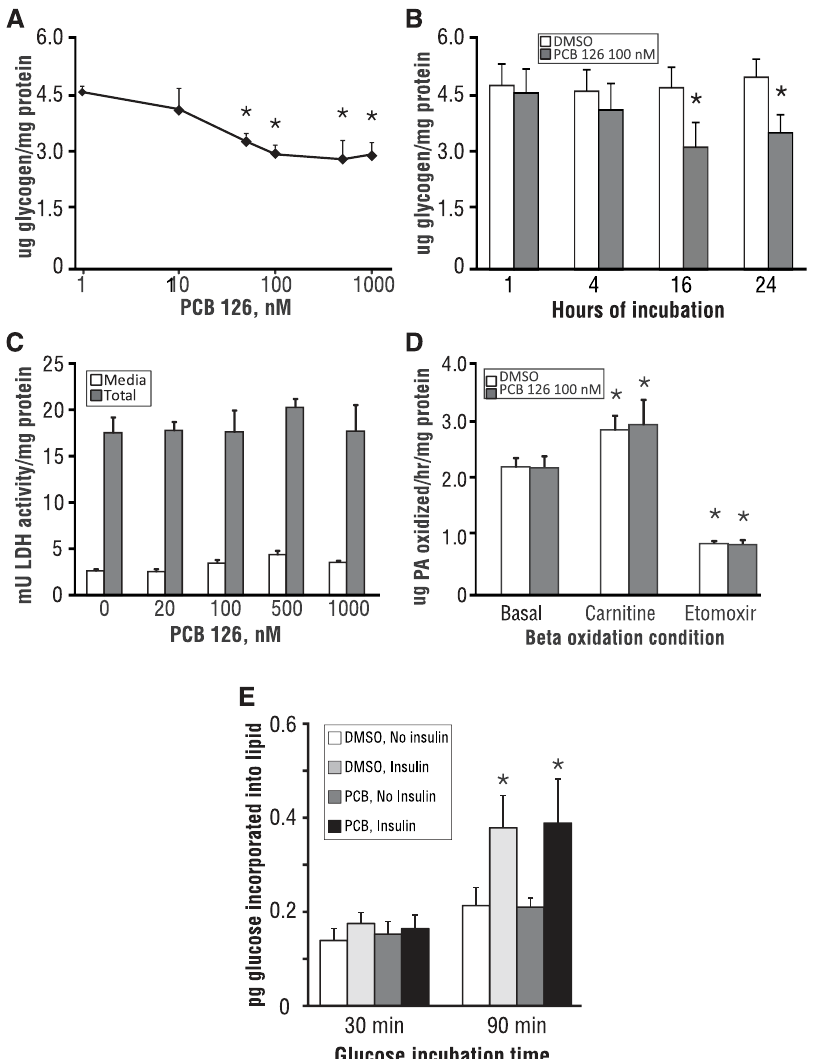
Figure 1. Preliminary validation of PCB effects on metabolic functions and toxicity in primary mouse hepatocytes. (A) Suppression of total intracellular glycogen by increasing doses of PCB 126; *p , 0.05 vs. DMSO control. (B) Maximum suppression of total intracellular glycogen at 100 nM PCB 126 after 16 h of incubation; *p , 0.05 vs. DMSO control. (C) PCB 126 is not cytotoxic at up to 1 mM, and also does not affect cellular expression of LDH. (D) PCB 126 has no effect on mitochondrial beta oxidation of palmitic acid; *p , 0.05 vs. DMSO for each respective beta oxidation condition. (E) PCB 126 has no effect on basal or insulin-stimulated lipogenesis; *p , 0.05 for insulin effect vs. respective no-insulin control. Unless otherwise noted, all PCB treatments were 16 h in length. Data are average of 3 experiments; error bars are 2 / +